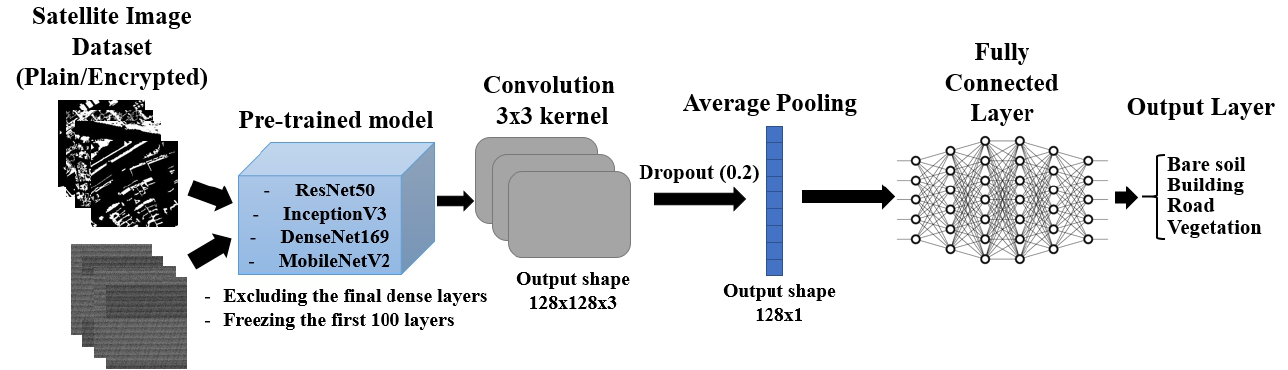
Figure 8. Model architecture used for training on the plain and encrypted